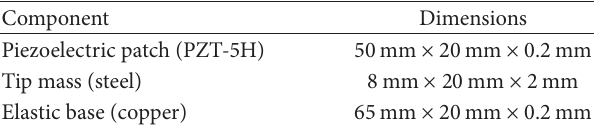
Table 2: Geometric dimensions of the bimorph cantilever